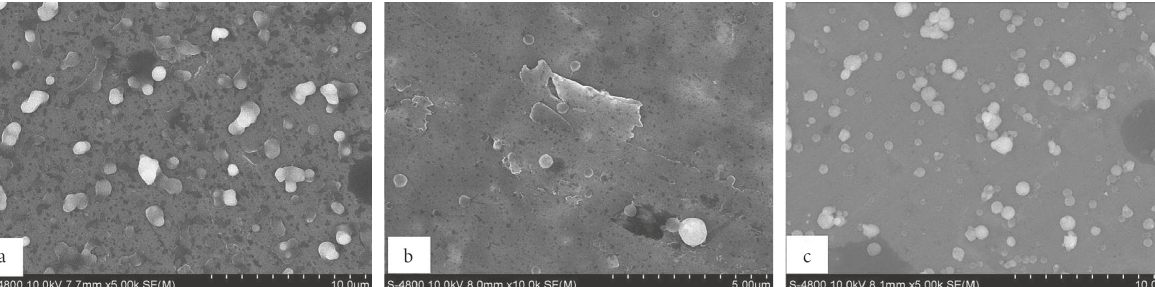
18kV, L 12 cm; (c) M3 chitosan at U (cid:30) (cid:30)